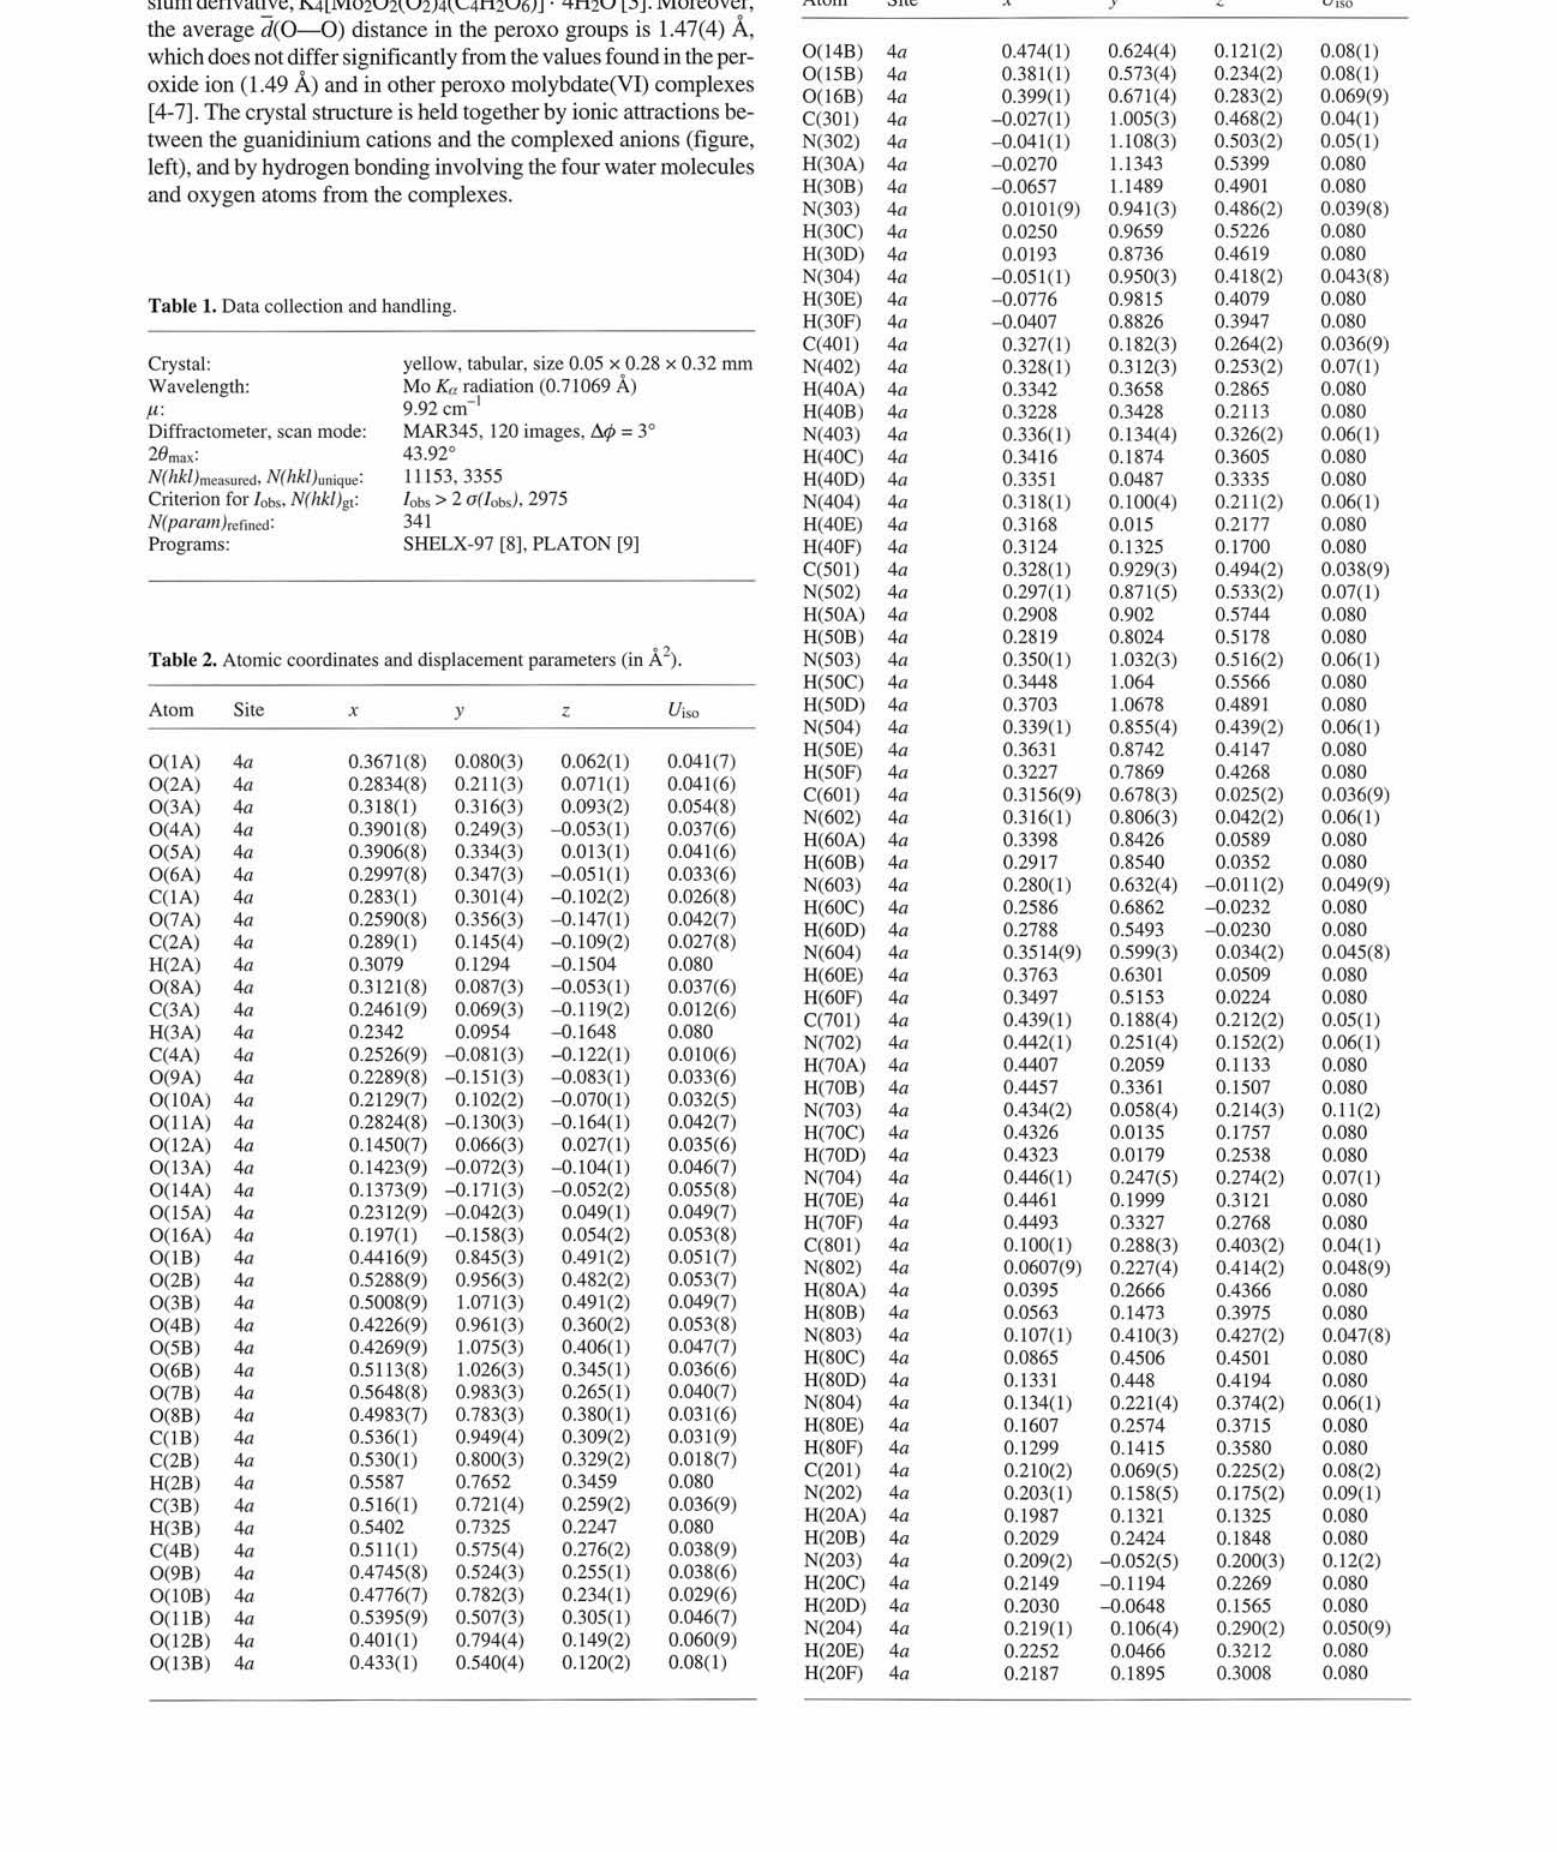
Table 2. Atomic coordinates and displacement parameters (in Â